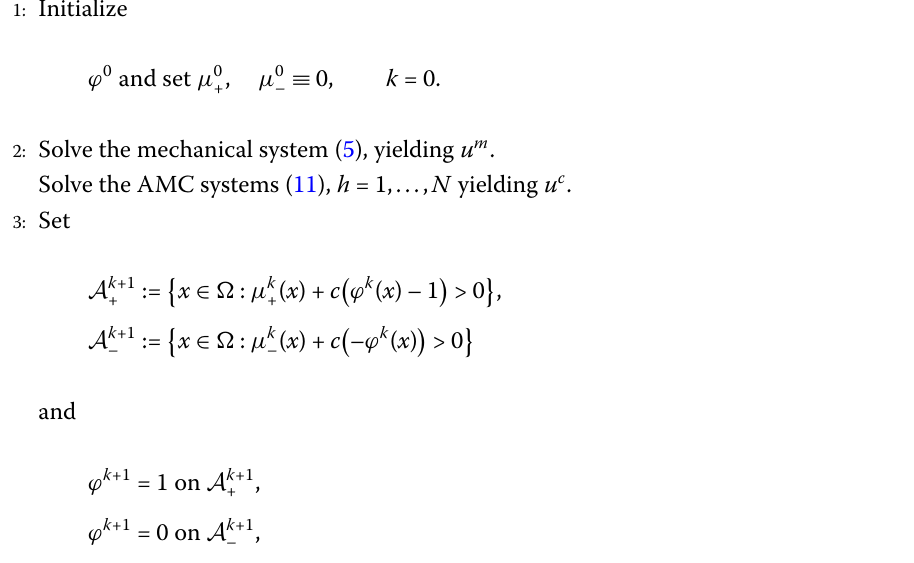
Algorithm 1 Primal-Dual